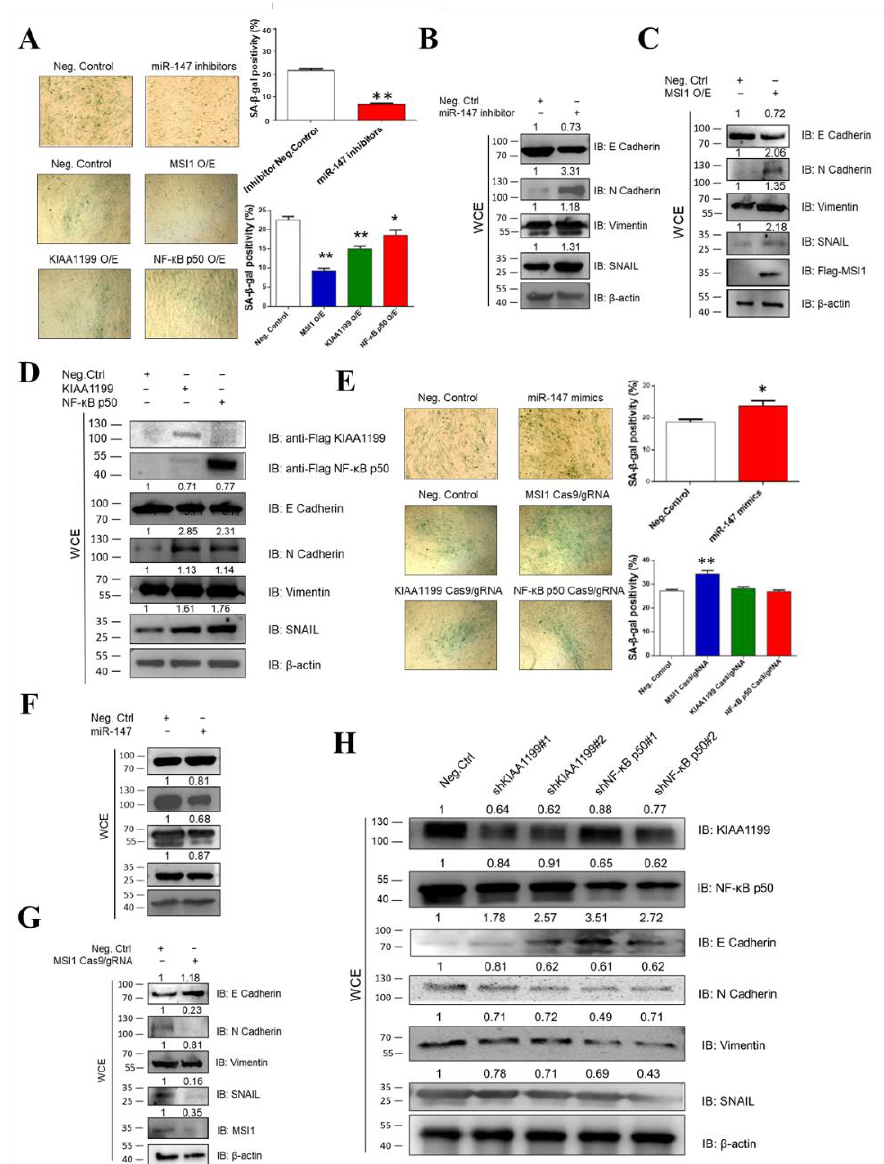
Figure 3. Overexpression of MSI1, KIAA1199, and NF- κ B p50 and inhibition of miR-147 were all associated with oncogenicity. ( A ) Senescence-associated (SA) β -Gal staining revealed that miR-147 inhibitor, overexpression of MSI1, KIAA1199, and NF- κ B p50 blocked cellular senescence. Negative control was transfected into CEFs at 4 dpi, after which SA β -Gal staining was performed at 48 h post-transfection (100 × ). ( B ) miR-147 inhibitor activated EMT in CEFs at 48 hpi, as detected using WB. ( C ) Overexpressing MSI1 activated EMT in CEFs at 48 hpi, as detected using WB. ( D ) Overexpressing KIAA1199 and NF- κ B p50 activated EMT in CEFs at 48 hpi, as detected using WB. ( E ) miR-147 mimics and the inhibition of MSI1, KIAA1199, and NF- κ B p50 promoted cellular senescence. Negative control was transfected into CEF cells at 4 dpi and SA β -Gal staining was performed 48 h post-transfection (100 × ). ( F ) miR-147 mimics decreased EMT in CEFs at 48 hpi, as detected using WB. ( G ) Inhibiting MSI1 decreased EMT of CEFs at 48 hpi, as detected using WB. ( H ) Inhibiting KIAA1199 and NF- κ B p50 decreased EMT of CEFs at 48 hpi, as detected using WB. ** p ≤ 0.01 determined using Student (cid:48) s t -test versus the Neg. Ctrl. group. * p ≤ 0.05 determined using Student (cid:48) s t -test versus the Neg. Ctrl.